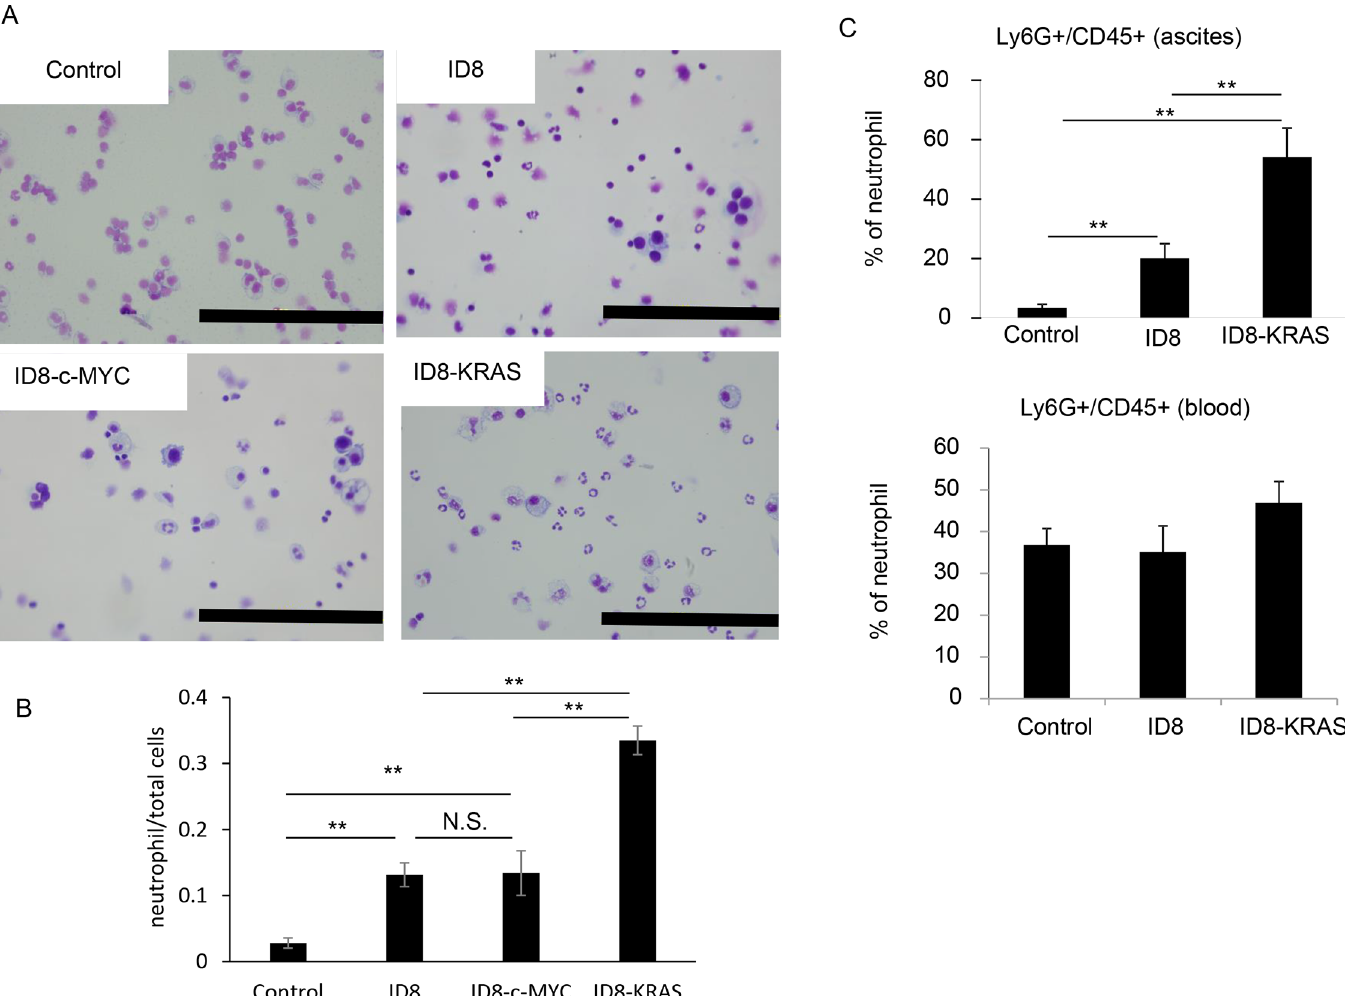
Fig 4. Proportion of leukocytes in ascites. ID8, ID8-c-MYC, or ID8-KRAS cells (2 × 10 6 ) were intra-peritoneal injected into C57/BL6 mice. Mice were sacrificed when the body weight reached 23 g and ascites and blood were collected. Leukocytes of ascites and blood were isolated using positive selection of CD45. (A) Populations of leukocytes in the ascites were observed with Giemsa staining (2.0×10 5 cells/mL, n = 4 in each group). Representative data was shown. Scale bars indicate 200 μ m. (B) Number of neutrophils among total cells in nine high-power fields were counted in each group. Error bars represent the mean ± SEM. A statistical analysis was performed with the Student ’ s t-test ( ** P (cid:1) 0.01, n.s. indicates not significant.). (C) The proportion of CD45 Ly6G- positive neutrophils was assessed using flow cytometry (control: n = 4, ID8: n = 6, ID8-Kras: n = 6). Neutrophils were stained with the following antibodies: FITC-anti-mouse CD45 and APC-anti-mouse Ly6G. Error bars represent the mean ± SEM. A statistical analysis was performed with the Student ’ s t-test ( ** P (cid:1) 0.01).